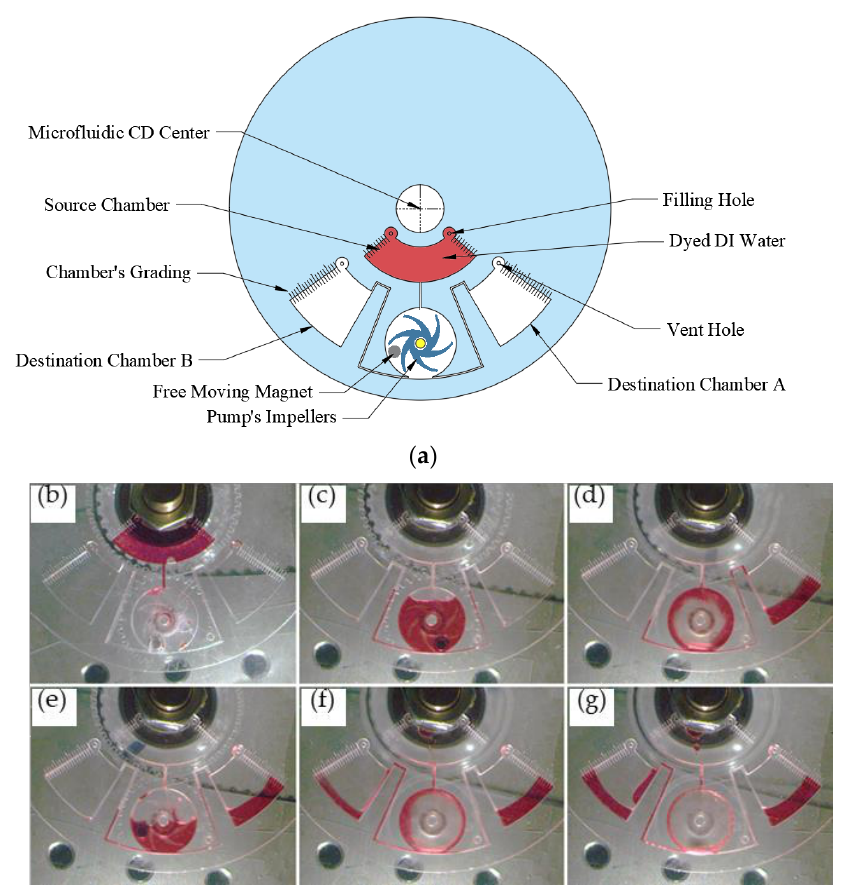
Figure 9. Flow-switch pumping design and experimental results: ( a ) Microfluidic CD design for the flow-switch pumping ( b – g ) experimental progress of the flow-switch pumping.